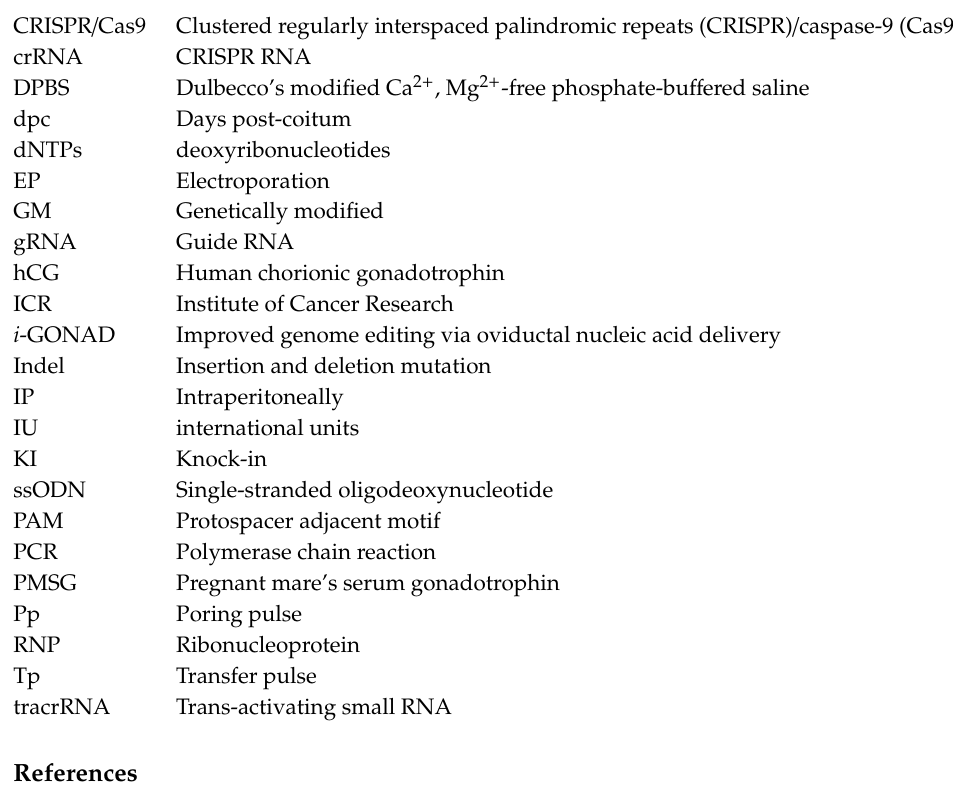
Figure S1: Adjustment of the distance between the two electrodes to obtain optimal current (A–D) and abnormal embryos (E,F), probably caused by a high current. Table S1: Detailed results of i -GONAD using B6 mice when relatively stringent electric conditions were employed. Table S2: Detailed results of i -GONAD using B6 mice when less stringent electric conditions were employed. Table S3: Detailed results of i -GONAD using BALB / c mice when relatively stringent electric conditions were employed. Table S4: Detailed results of i -GONAD using BALB / c mice when less stringent electric conditions were employed. Table S5: Detailed results of i -GONAD using ICR mice when GEB21 electroporator was used. Table S6: Detailed results of i -GONAD using B6 mice when GEB21 electroporator was used. Table S7: Detailed results of i -GONAD using B6 mice when NEPA21 electroporator was used for low-dose PMSG-treated females. Table S8: Detailed results of i -GONAD using BALB / c mice when NEPA21 electroporator was used for low-dose PMSG-treated